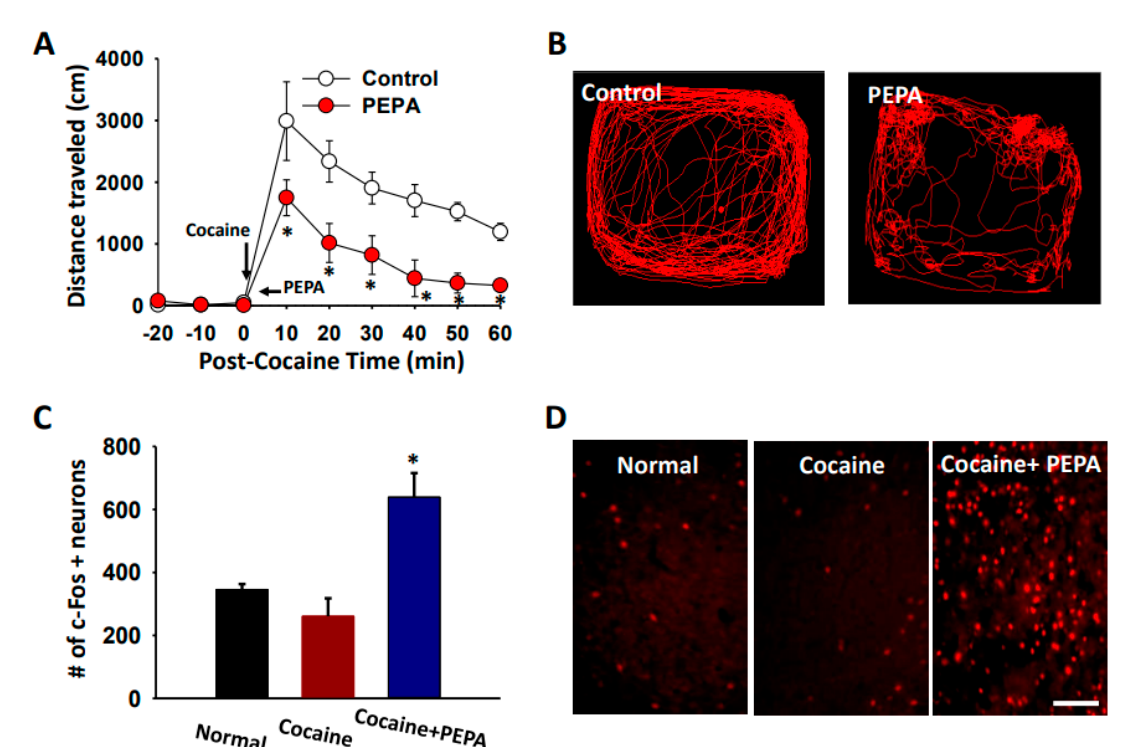
Figure 5. Reduction in cocaine locomotion by LH activation ( A , B ). Effect of PEPA injection on cocaine-induced locomotor activity in rats. PEPA microinjection into the LH reduced the mean distance traveled per 10 min following cocaine injection, compared to control group (cocaine injection only). Representative moving traces for 60 min after cocaine injection ( B ). Control, cocaine injection only ( n = 5); PEPA, PEPA microinjection into the LH after cocaine injection ( n = 5). * p < 0.05 vs. Control. ( C , D ) Enhanced c-Fos expression following PEPA injection into LH. Mean numbers of c-Fos positive neurons in control, cocaine and PEPA groups ( C ) and representative images of c-Fos expression in LH ( D ). Normal, normal rats ( n = 5); Cocaine, cocaine-treated rats ( n = 4); Cocaine + PEPA, microinjection of PEPA into LH in cocaine-treated rats ( n = 4). * p < 0.05 vs. Normal or Cocaine. Bar = 100 μ m.